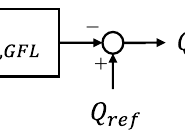
Figure 6. Controller model of the VI-GFL.